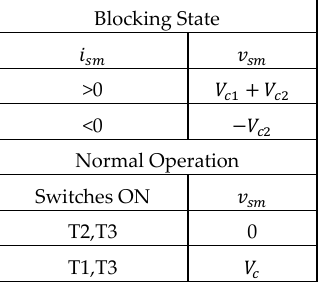
2𝑉 (cid:3030) Figure 10. CDSM.